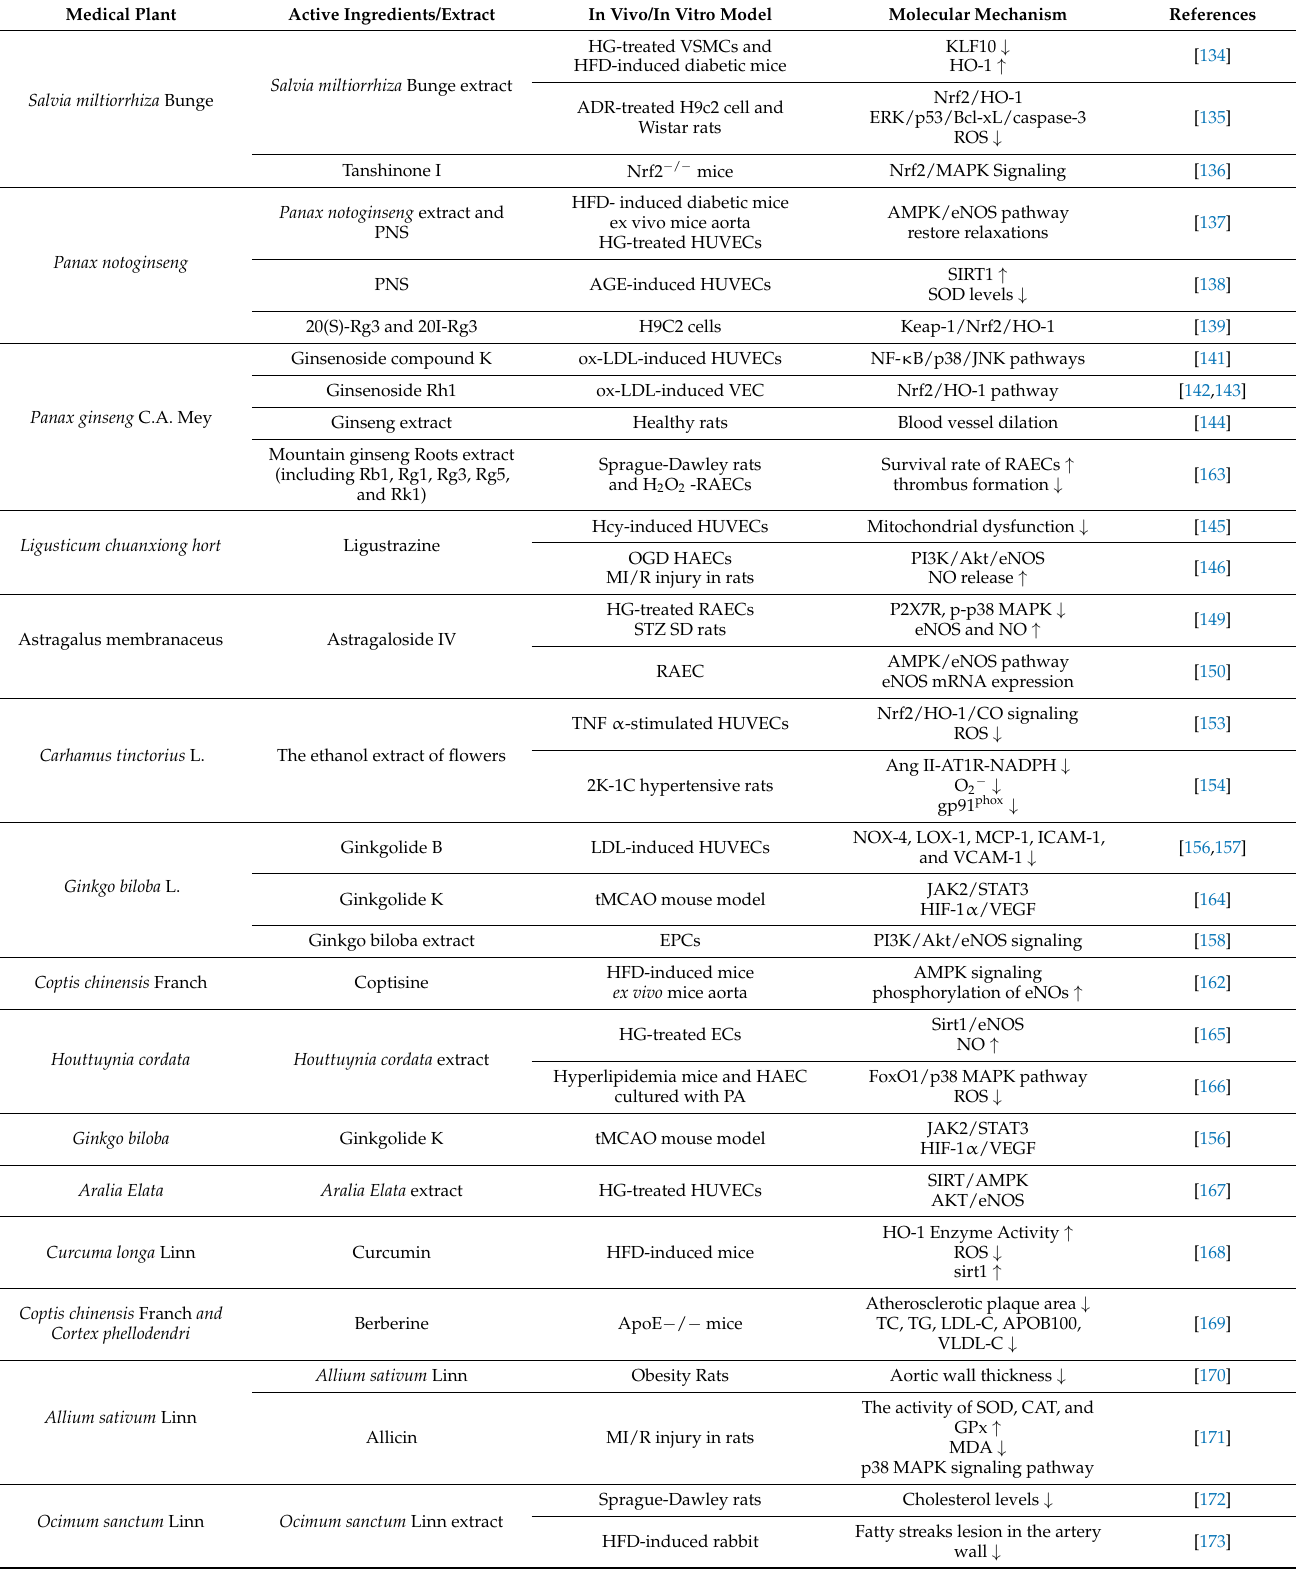
Table 2. Antioxidant effects of medicinal plants and their bioactive compounds in improving cardio- vascular disease in experimental settings. ↑ : upregulation; ↓ :